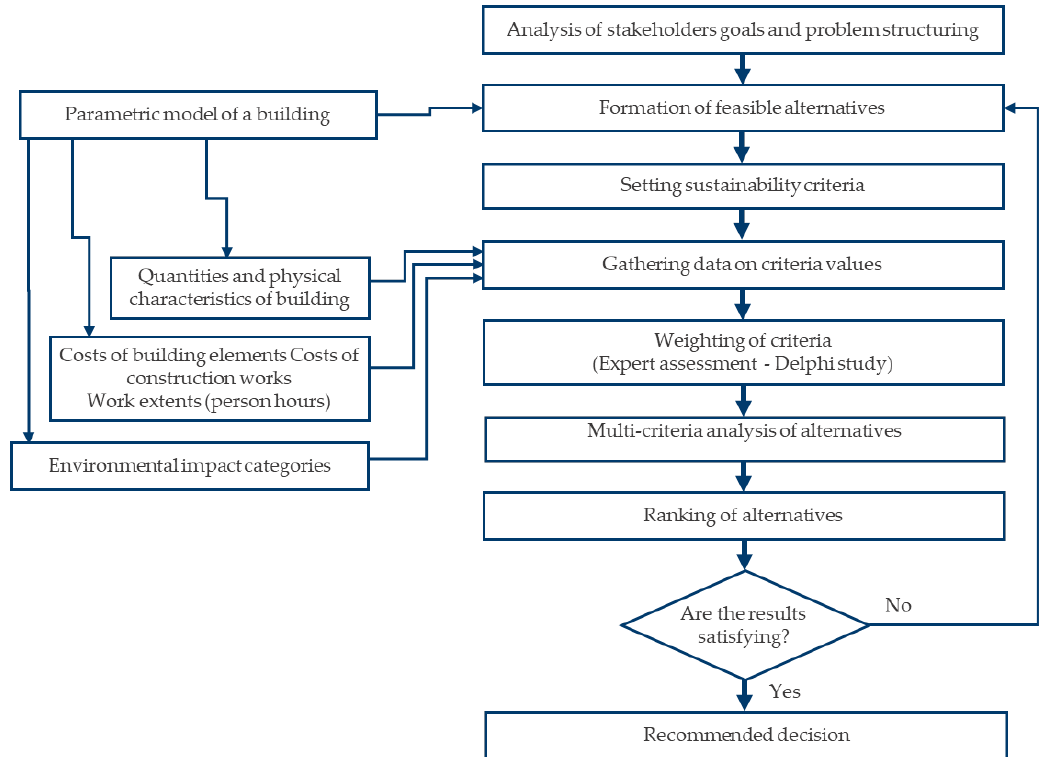
Figure 2. The structure of the hybrid decision model, based on the multi-criteria aiding methods and Delphi technique.